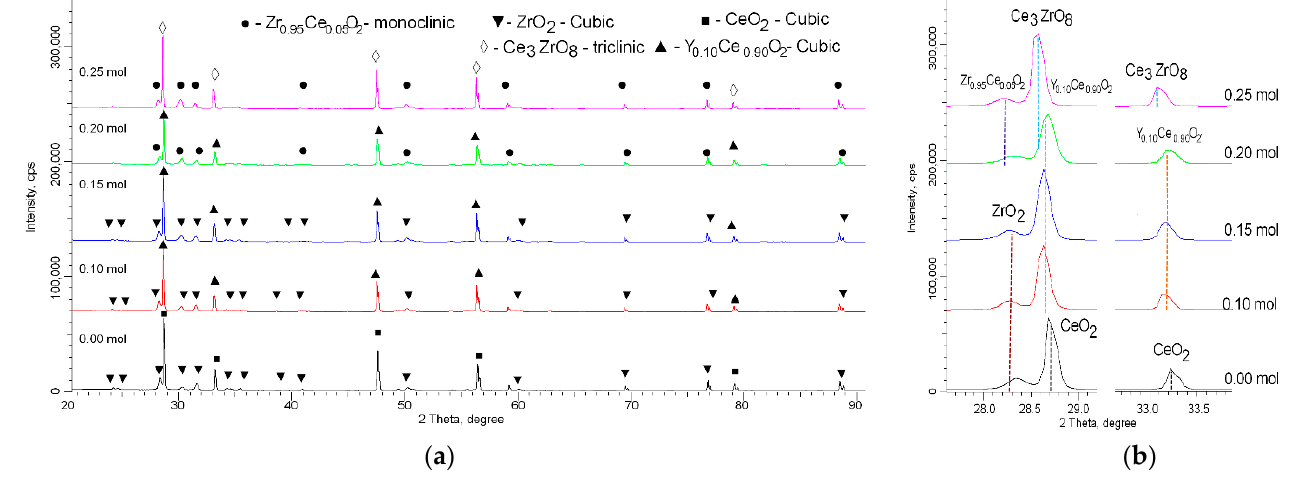
Figure 2. ( a ) X-ray diffraction patterns of the studied samples, depending on the dopant concentration. ( b ) Detailed representation of change in the position of diffraction reflections when determining the phase